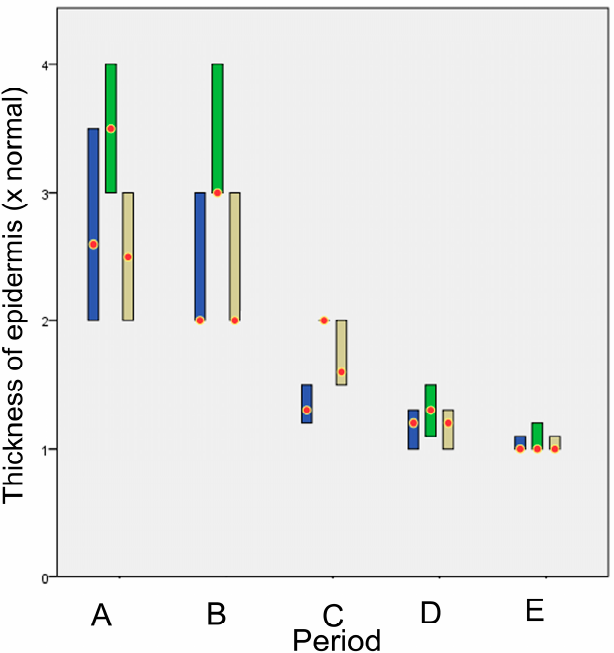
Figure 15. Median (red dot) and interquartile range (column) of the thickness of the epidermis at the wound area (number of times the epidermis thickness is greater than the adjacent healthy epidermis) for each technique (blue: staples, green: glue, gray: intradermal) in each period. [period A: 1–8 po.d.; period B: 9–21 po.d.; period C: 22–63 po.d.; period D: 64–180 po.d.; period E: 181–365 po.d.]. In period B glue was significantly different from intradermal ( p = 0.009), and in period C glue differed significantly from staples ( p < 0.001).